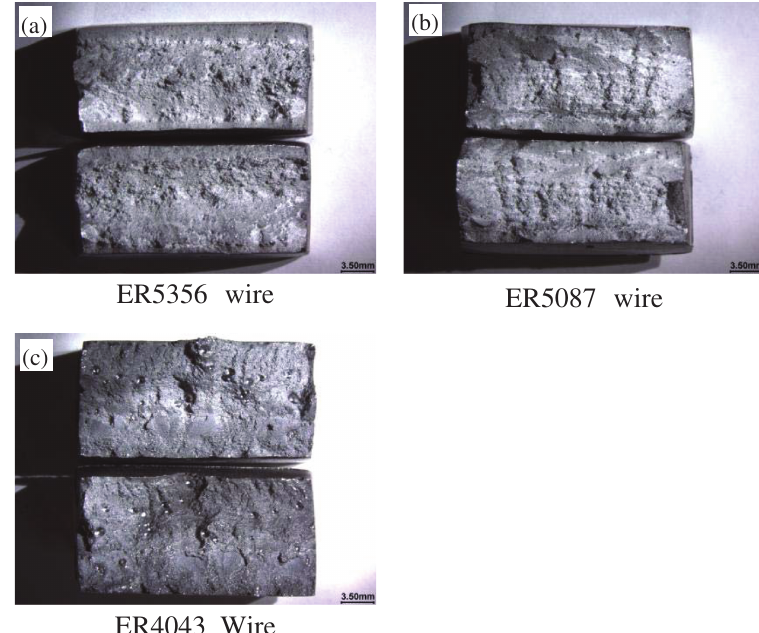
Figure 9: The macroscopic topography of the fracture.